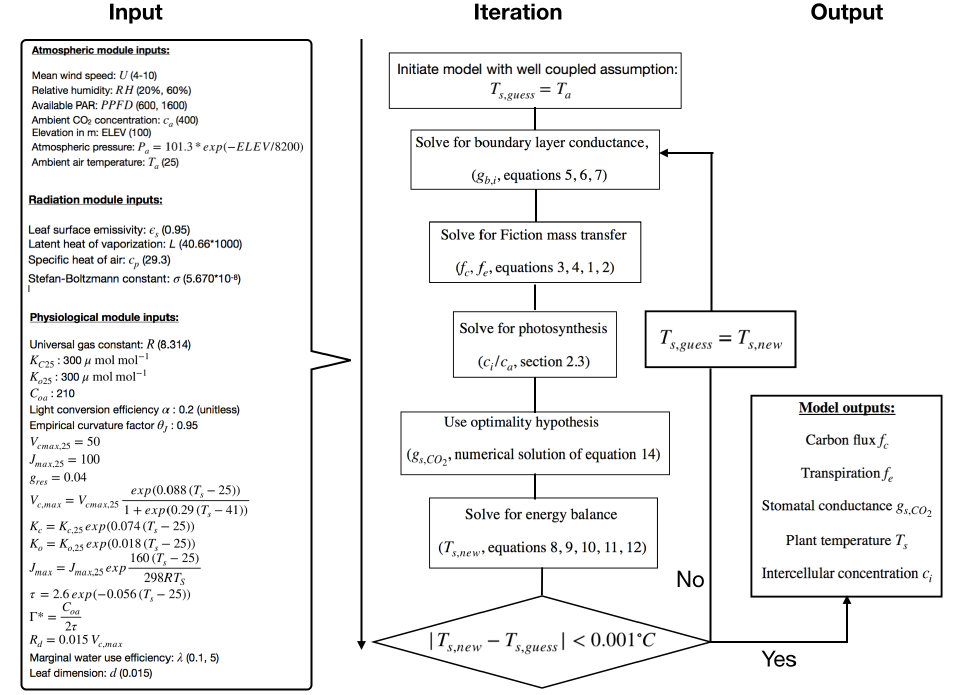
Figure 1. Algorithm for the plant physiological model adapted from Huang et al. [18].